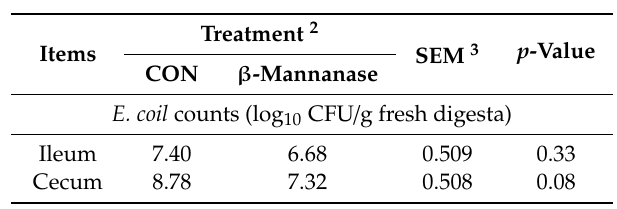
Table 5. E ff ects of dietary supplementation of β -mannanase on the count of E. coil in ileum and cecum of weaning pigs 1